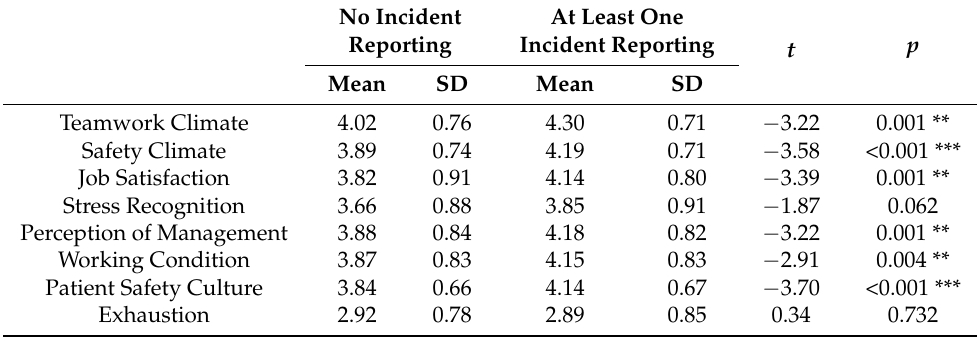
Table 5. Differences between means by incident reporting.